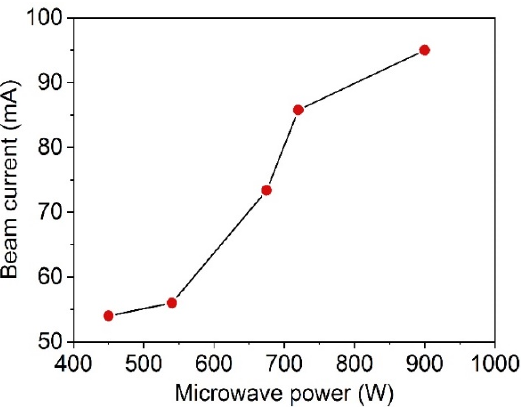
Figure 9. The extraction beam current under different inputs of microwave power.